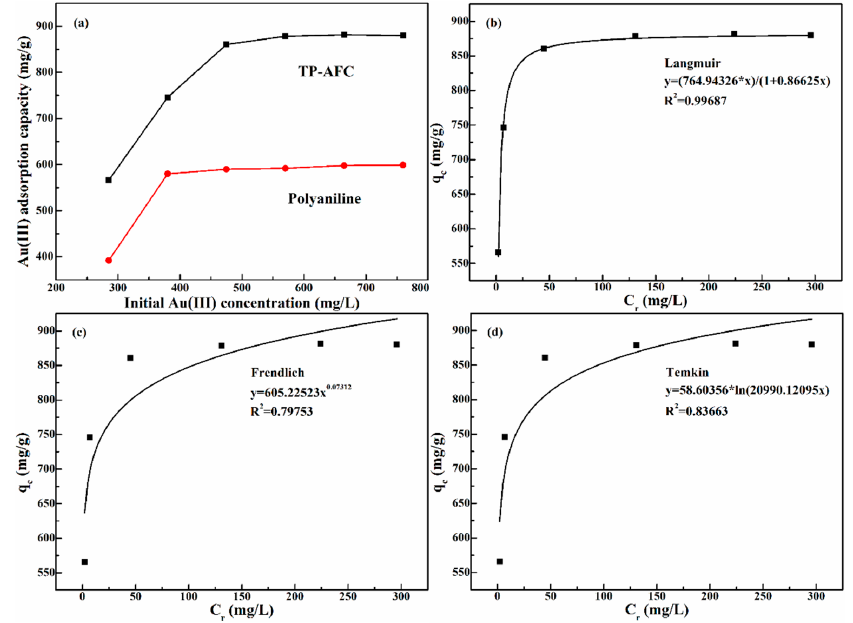
Figure 5. ( a ) the Au(III) concentration e ff ect on adsorption capacity, isothermal adsorption model of gold on TP-AFC ( b ) Langmuir ( c ) Freundlich and ( d )